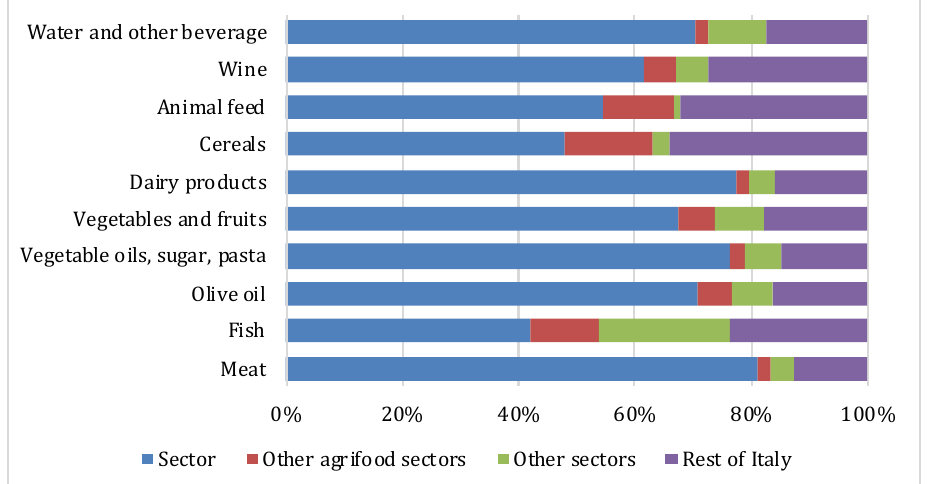
Figure 3. Share of Basilicata’s food sectors to the various “blocks” of the production